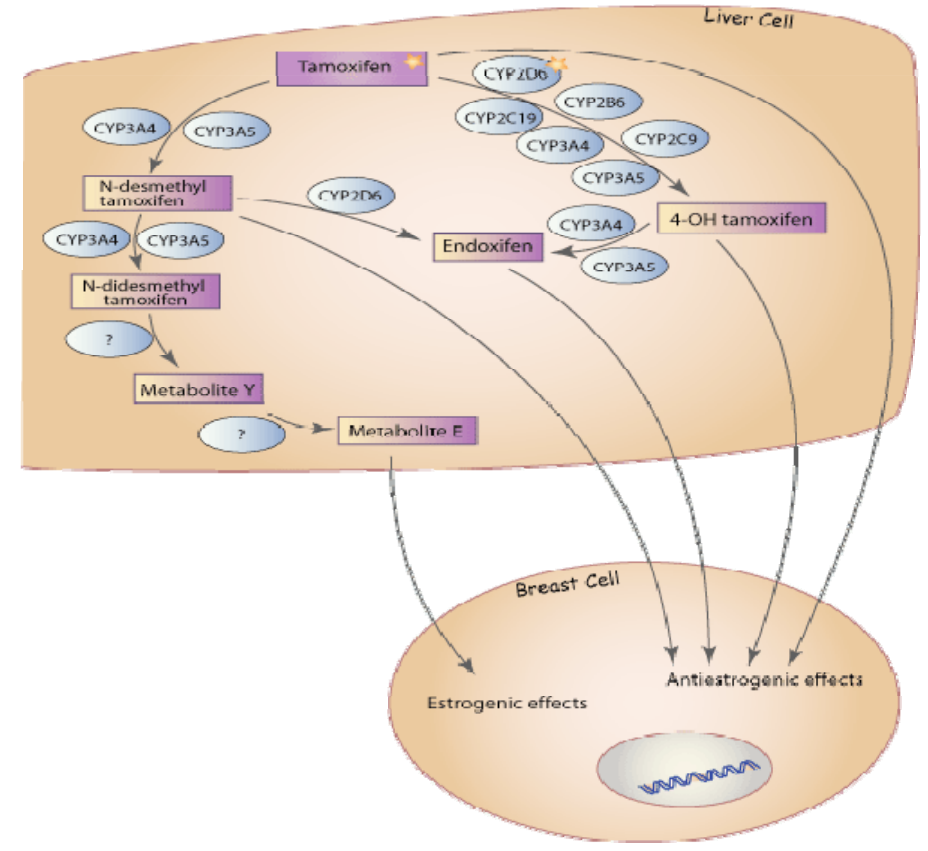
Figure 1. Tamoxifen metabolism in the liver. CYP3A4 and CYP3A5 are the major enzymes responsible for N -demethylation, whereas 4-hydroxylation is predominantly mediated by CYP2D6. Reprinted with permission. © 2009 PharmGKB. All rights reserved.